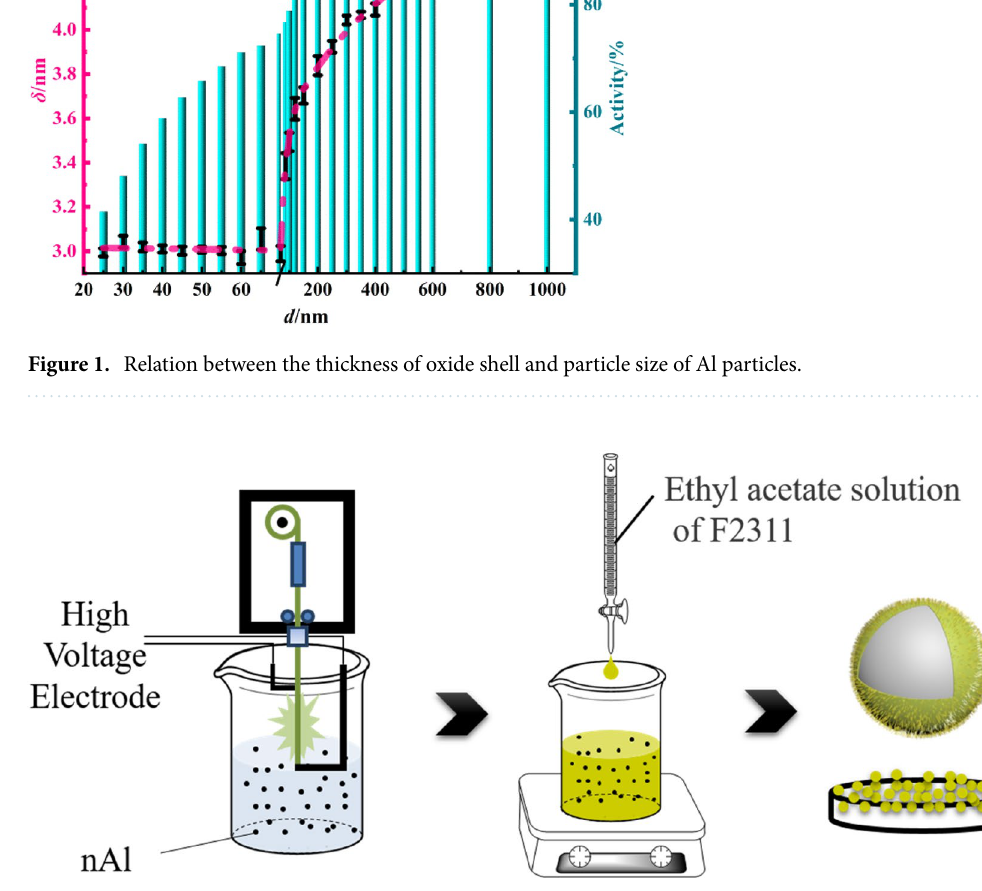
Figure 2. Preparation process of F2311 encapsulated aluminum